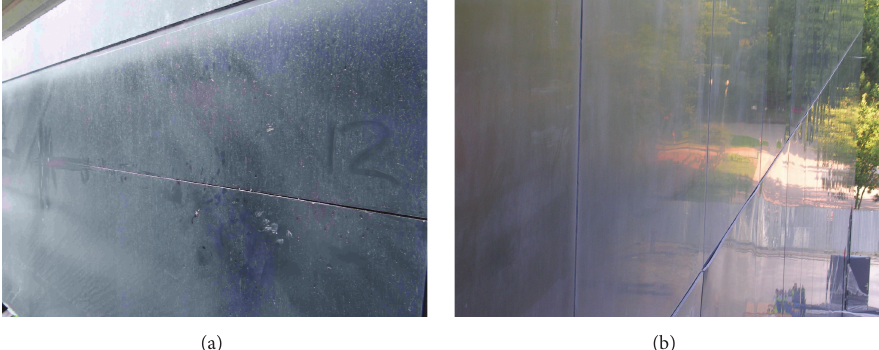
Figure 2: Damages of the Corian panels of “Afrykanarium” building in Wrocław: (a) cracking in the winter and (b) deformations of panel edges in the summer.